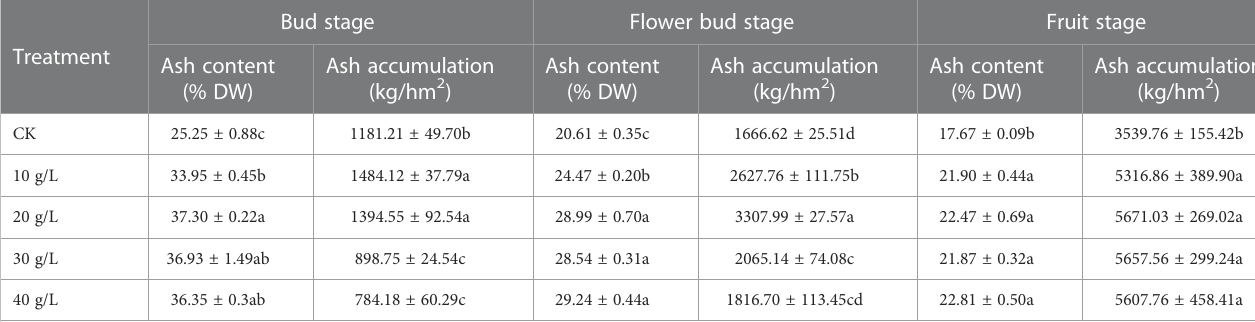
TABLE 4 Ash content and concentration of S. salsa under irrigation with water of different